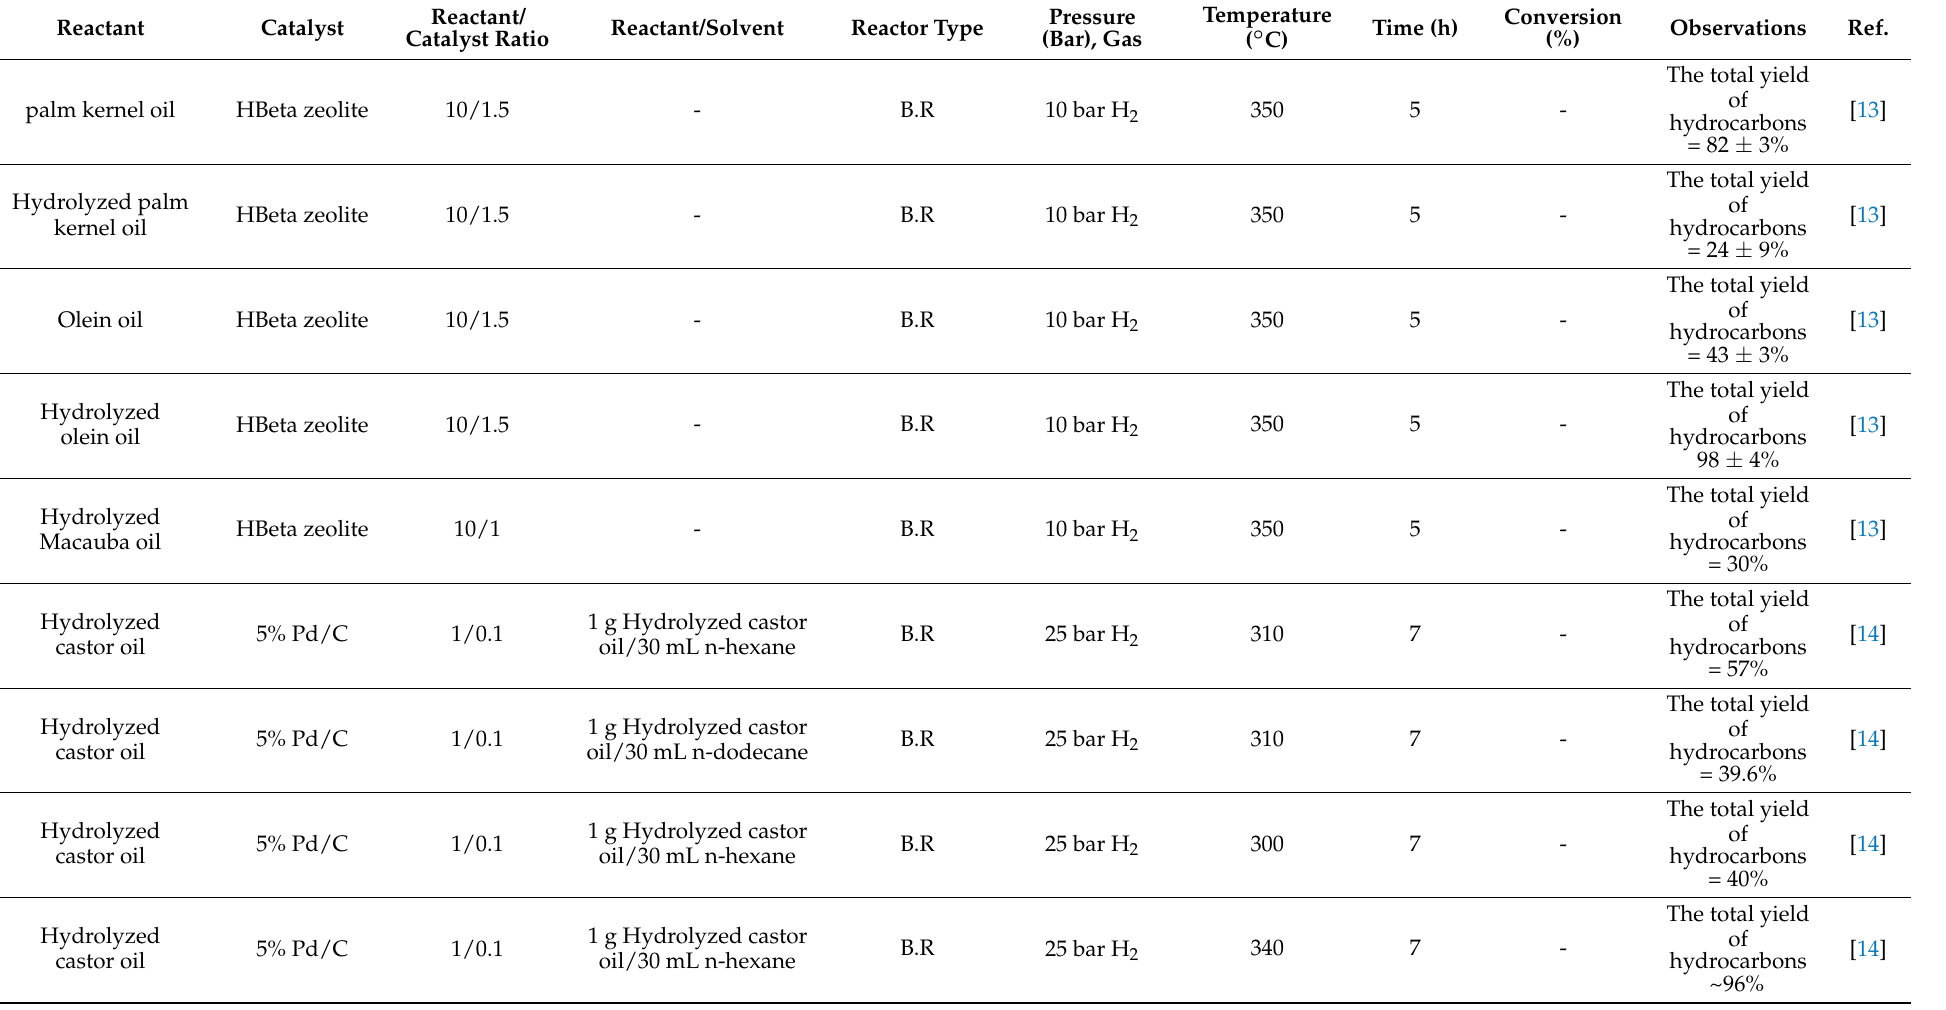
Table 7. Hydrocarbon production via catalytic deoxygenation with various catalyst types in references and catalytic deoxygenation investigated in this